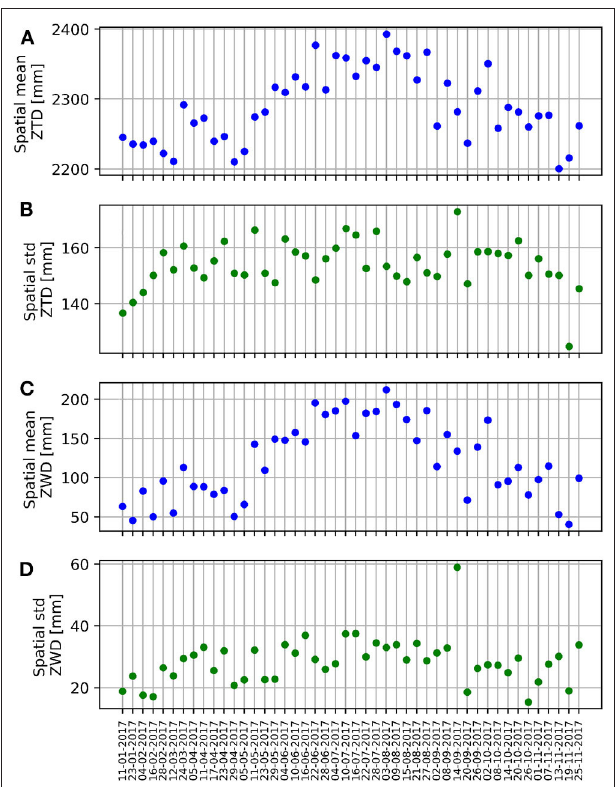
FIGURE 2 | ZTD and ZWD spatial statistics as measured by the 26 GNSS stations of the SPIN network described in the main text. (A,B) are the mean and standard deviation of the ZTD; (C,D) for the ZWD. Note the different y-axis